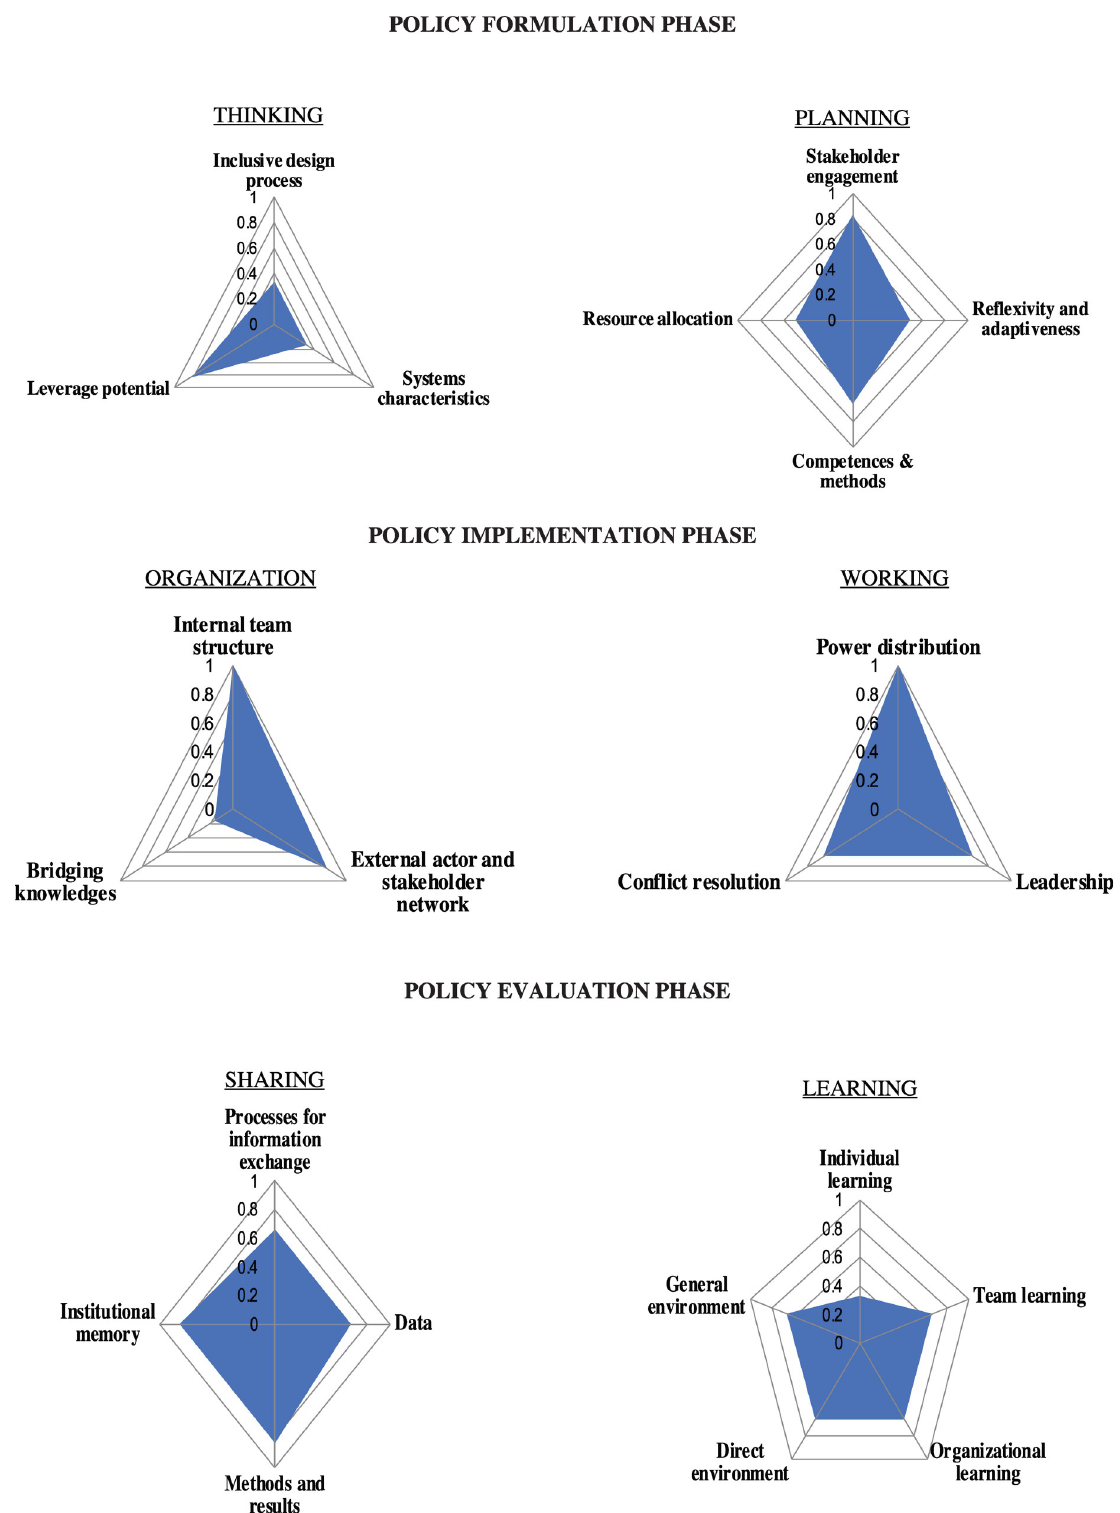
Fig 4. Evaluation results obtained with the EVOLvINC tool for the aspects contributing to the knowledge integration capacity during the formulation phase, implementation phase and evaluation phase of the policy cycle. Scores are medians and range from zero (not supportive for knowledge integration) to one (highly supportive for knowledge integration). The figure indicates that there is potential